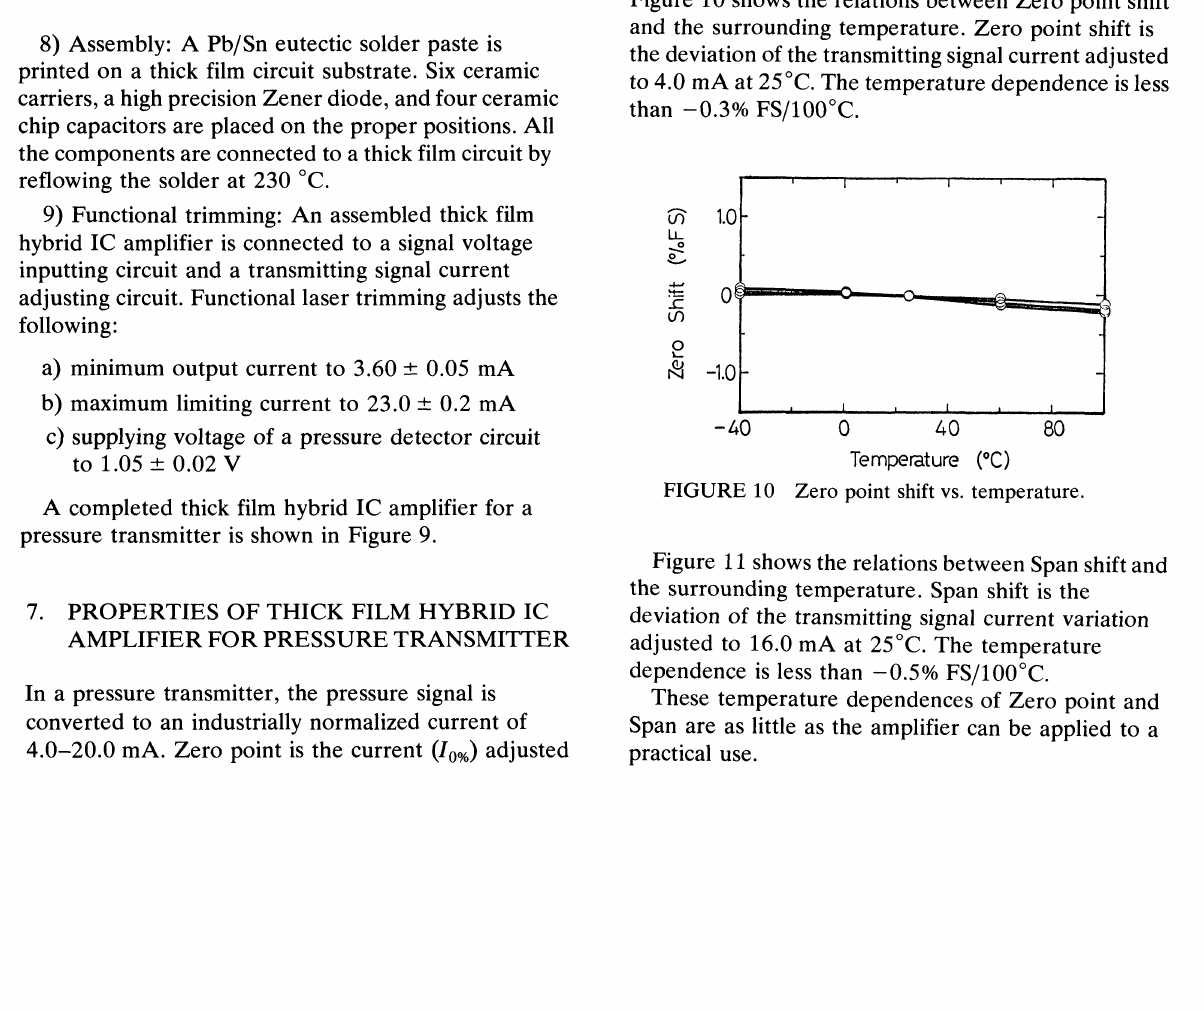
FIGURE 9 Thick film hybrid IC amplifier for pressure transmitter (53.0 50.0 mm in size).